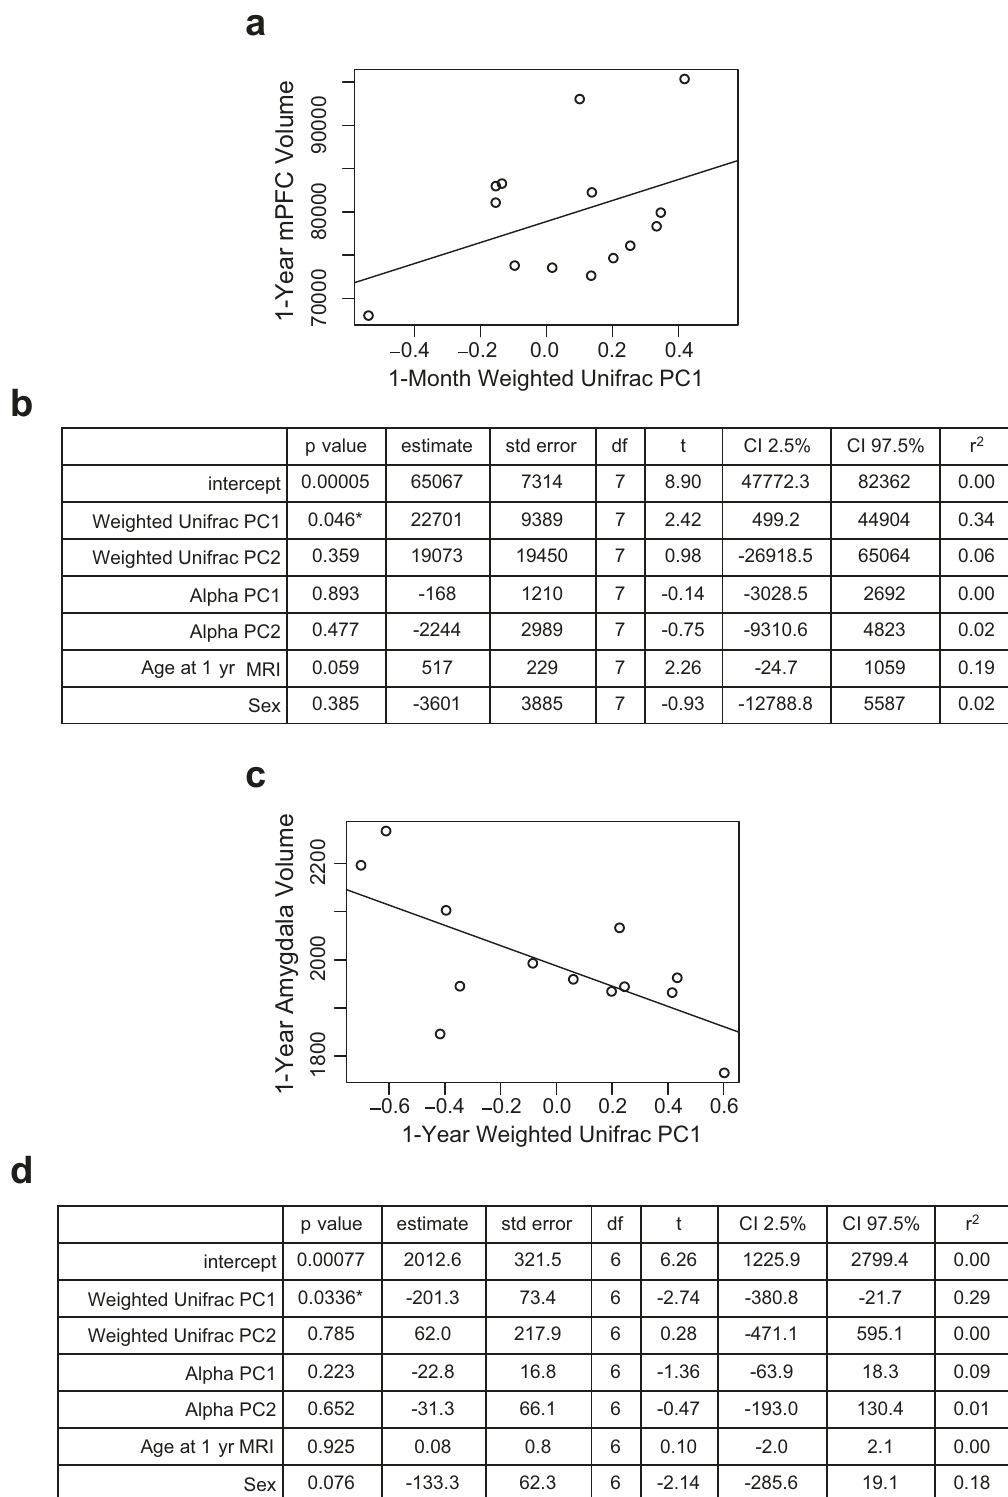
Fig. 6 Associations between microbiome and fear-related brain structure volumes. a Scatterplot displaying relationship between 1-month Weighted Unifrac principal coordinate 1 and 1-year medial prefrontal cortex volume. Each dot represents a single subject. b Multiple linear regression model with t test of microbiome predictors at 1-month and 1-year medial prefrontal cortex brain volume, * denotes p < 0.05 but not meeting threshold for Bonferroni signi fi cance, n = 14 independent participants, covariates include age at scan and sex. c Scatterplot displaying relationship between 1-year Weighted Unifrac principal coordinate 1 and 1-year amygdala volume. Each dot represents a single subject. d Multiple linear regression model with t test of microbiome predictors at 1-year and 1-year amygdala brain volume, * denotes p < 0.05 but not meeting threshold for Bonferroni signi fi cance, n = 13 independent participants, covariates include age at scan and sex. Source data for this fi gure are provided as a Source Data fi